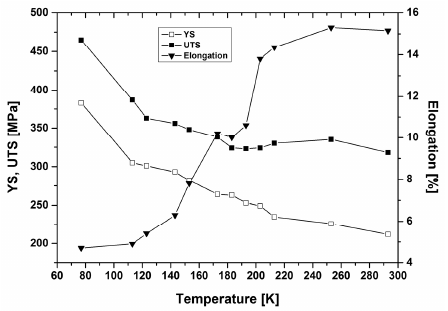
Figure 10. Temperature dependence of mechanical properties of AZ80 magnesium alloy (redrawn after [24]).